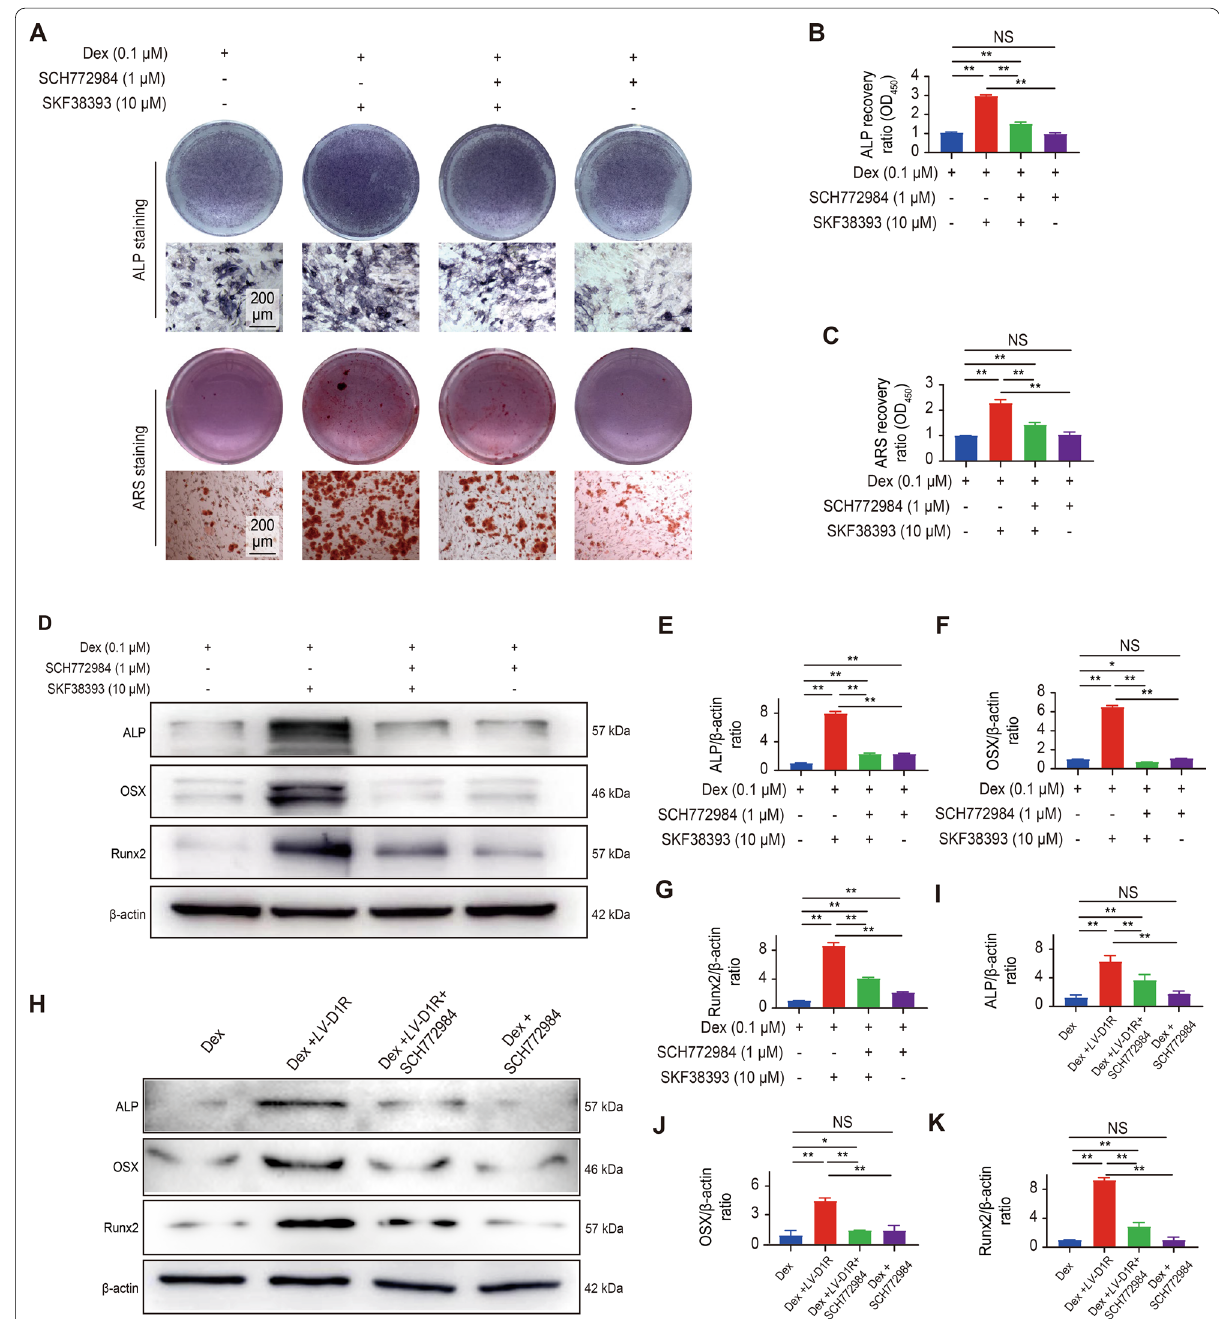
Fig. 5 The ERK1/2 pathway was involved in the protective effect of D1R against Dex-mediated inhibition of osteoblast differentiation. A Representative images showing ALP and ARS staining. Scale bar: 200 μm. B and C Quantitative analysis of ALP and ARS staining. n NS: Not statistically significant, * p < 0.05, ** p < 0.01, vs. the control group. D Representative images of western blots probed with antibodies against ALP, OSX and Runx2. E – G Quantification of ALP, OSX and Runx2 protein levels. n vs. the control group. H Representative images of western blots probed with antibodies against ALP, OSX and Runx2. I – K Quantification of ALP, OSX and Runx2 protein levels in the overexpression experiment. n